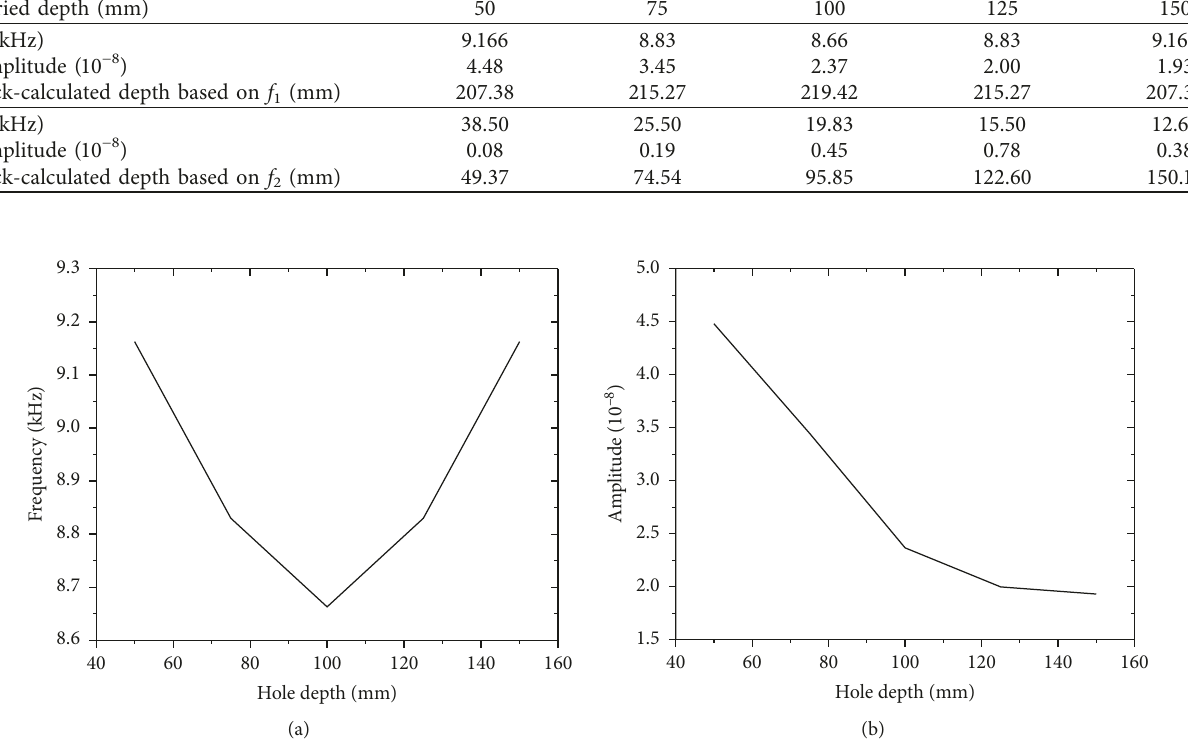
Figure 13: Relationships between frequency, amplitude and hole depth. (a) Relationship between frequency and hole depth. (b) Re- lationship between amplitude and hole